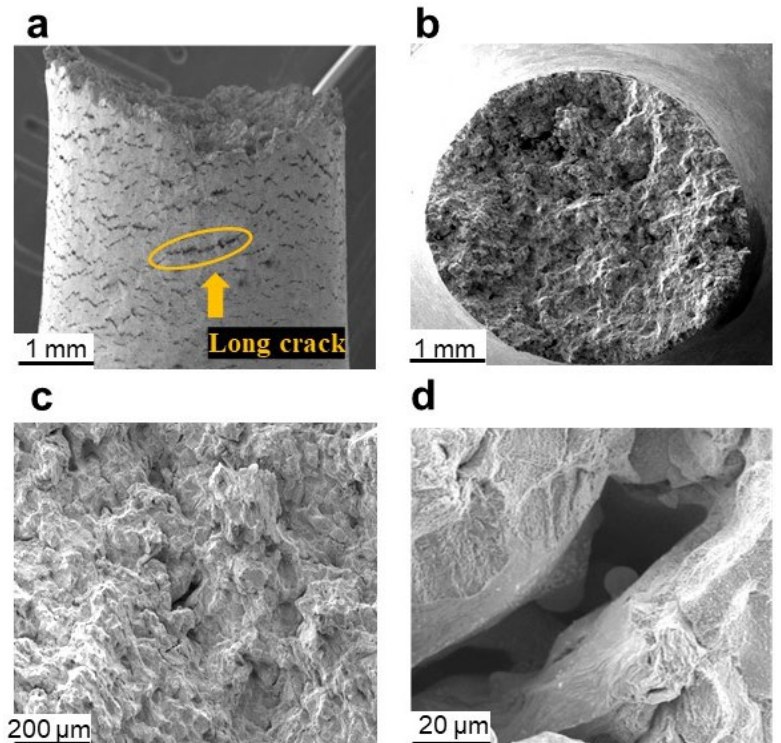
Figure 10. Fracture surface characterization of tensile failed 1175-WQ samples by using secondary electron images (SEM): ( a ) the side of the fracture; ( b ) the front view of the fracture sample; ( c , d ) the morphology of fracture under different magnifications.